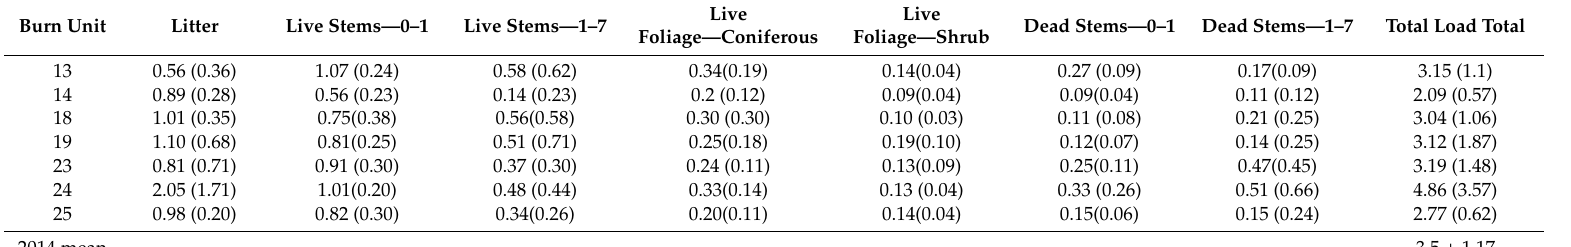
Table A6. Fuel loading per sample type for each summer burn